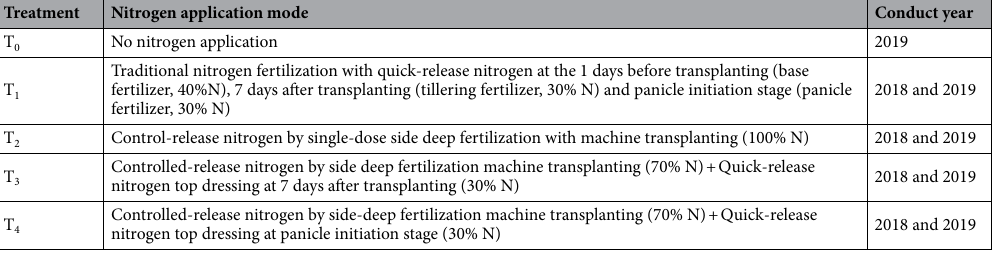
Table 9. Experimental nitrogen treatments applied in the study.